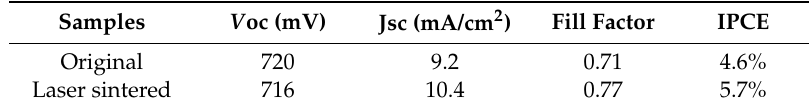
Table 1. Performance of the flexible dye-sensitized solar cells (DSCs) based on the laser sintered and unsintered TiO 2 films. IPCE: incident photon-to-electron conversion